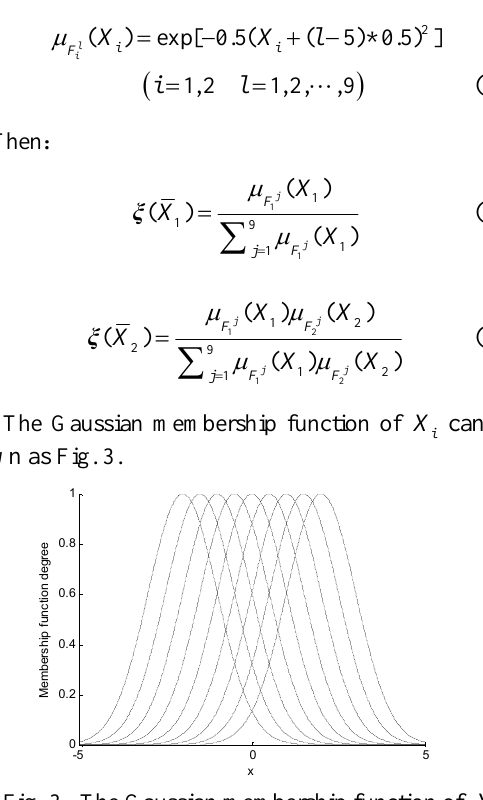
f and estimated  (f)  (g) 1 2 1